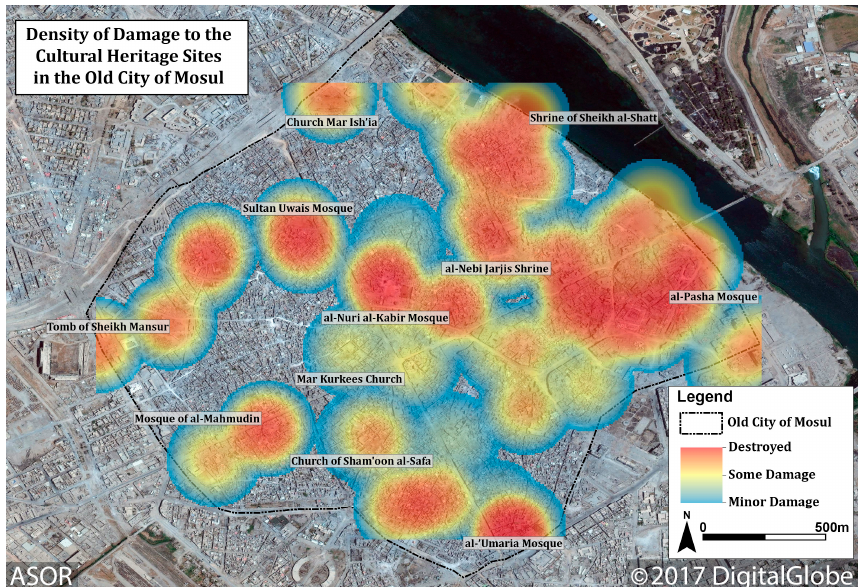
Figure 11. Density of damage to cultural heritage sites within the Old City of Mosul (ASOR CHI/DigitalGlobe NextView License; 12 July 2017).